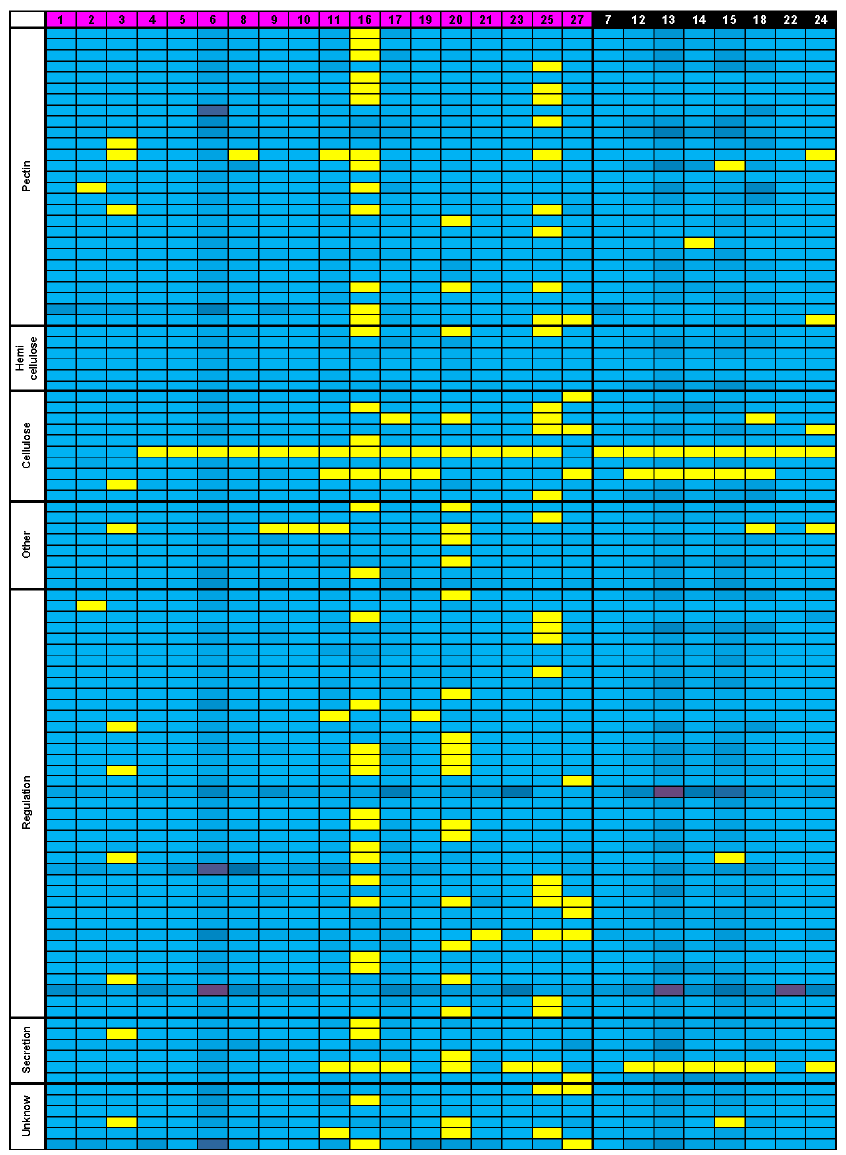
Figure 7. The presence of the A. thaliana MSC toolbox gene orthologs throughout the Brassicaceae family is unrelated to their myxospermous ability or lack thereof. Orthologous genes presence (blue) or absence (yellow) is highlighted for each A. thaliana MSC toolbox genes (in line) within each studied species (in column). Genes are grouped in functional catego- ries and their numbers for each species due to duplications are symbolized by a colored gradient from light blue (1 gene) to dark purple (23 genes). Species are identified with the number attributed in Figure 1, with myxospermous ones on the left side (in pink) and non-myxospermous ones on the right (in black). See Tables S4–S9 for more details.